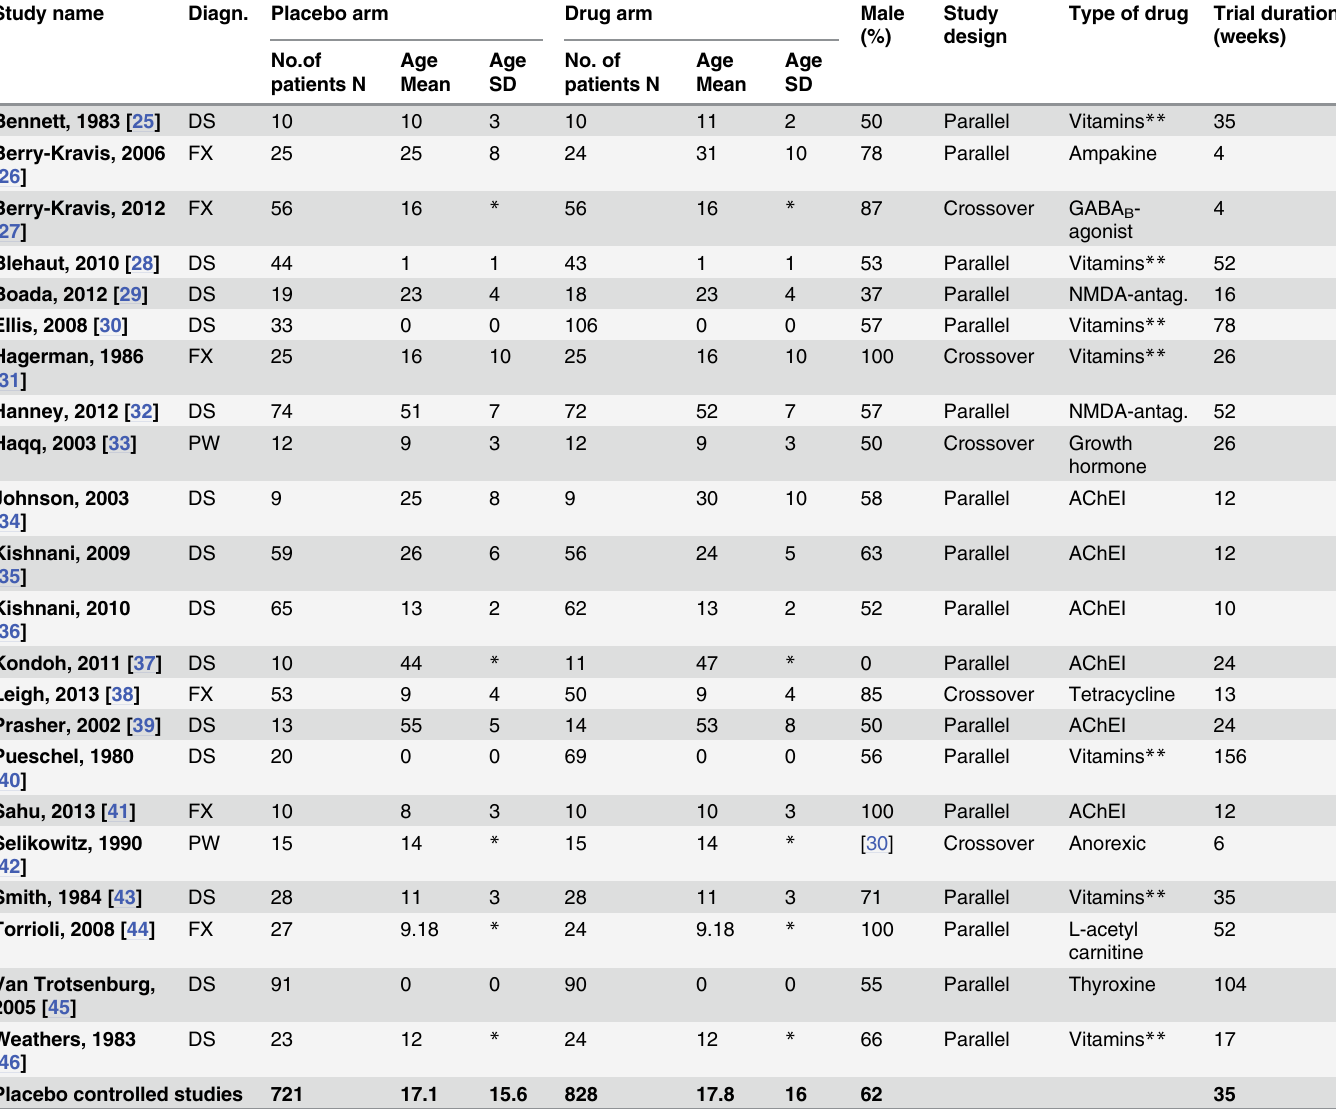
Table 1. Study characteristics. Descriptive features of the studies included in the placebo controlled trials of the